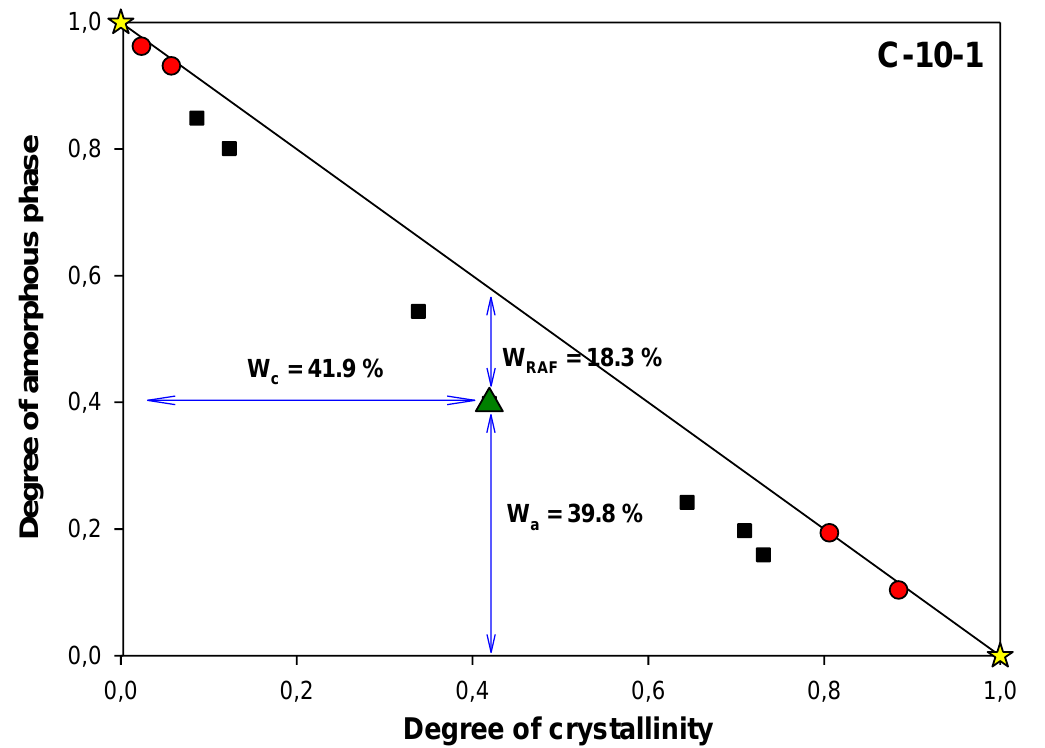
Figure 7. Dependence of the amorphous fraction as a function of the degree of crystallinity of the semicrystalline P3HB nanocomposite containing 1 wt.% of Cloisite ® 30B (denoted as C-10-1). The red points are characteristic of the two-phase model of nanocomposite, and the black squares show the three-phase model of C-10-1. The solid straight line indicates the full amorphous and full crystalline C-10-1 samples represented by the yellow star points. Table 4. Characterization of phase contents for the unfilled P3HB and its nanobiocomposites with Cloisite30B.